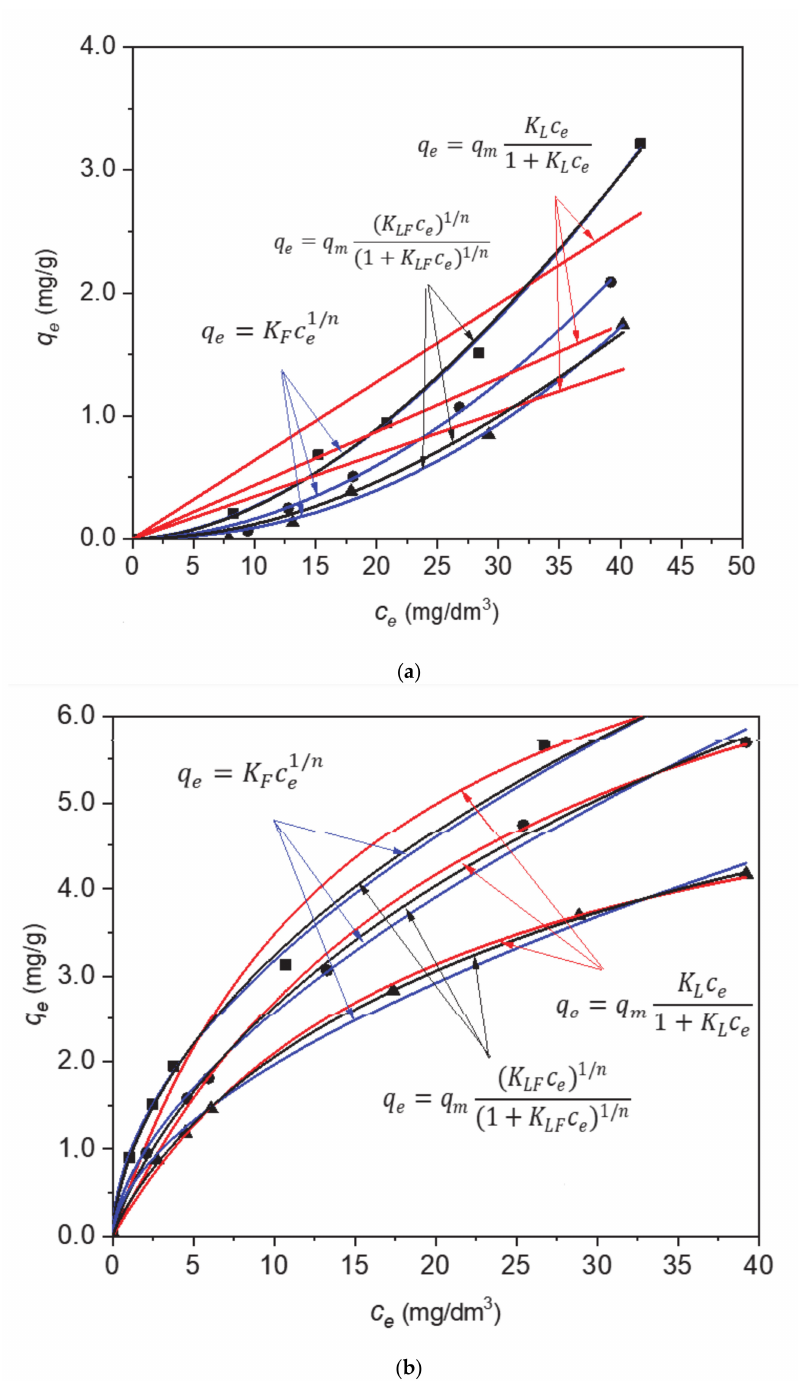
Figure 7. Calculation of adsorption equilibrium constant for paracetamol onto H ( a ) and 30C / H ( b ) adsorbents employing the experimental data. The lines represent the curve obtained by the application of the Freundlich and Langmuir (one-center and multi-center) equations with respect to the adsorption data as adjusted by the least-squares method. Temperature: (cid:4) 298 K; 303 K; (cid:78) 313 K. (cid:32) Langmuir isotherm models are represented by Equations (5) and (6) and Freundlich by Equation (7): q m K L C e Langmuir ( one − center ) q e = 1 +